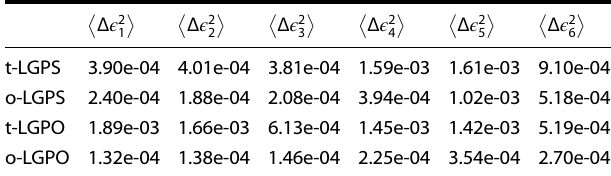
7. In turn, from these trajectories, we identify 47 uncorrelated blocks for t-LGPS (each block ~4 ps), 41 uncorrelated blocks for o-LGPS (each block ~4 ps), 16 uncorrelated blocks for t-LGPO (each block ~10ps), and 31 uncorrelated blocks for o-LGPO (each block ~5 ps). Next, we study the convergence of the elastic moduli on the simulation time. For each system we perform several calculations of the elastic moduli, each of them using only a part of the whole trajectory simulated, corresponding to n = 2, . . N blocks, N being the number of blocks that we have chosen for the whole trajectory (see above), and each block having the same length as determined from the block analysis on the whole trajectory. Then, for each of these calculations we obtain the standard errors of the moduli from the variance over the blocks, since these blocks are already uncorrelated and there is no need to repeat a block analysis for each of these calculations. The values of the moduli as a function of the simulation time, together with the related standard errors are reported in Fig. 4 for t-LGPS, whereas for the remaining three structures they are reported in Supplementary Figure 8. In Fig. 4, the errors of B , G , E, and ν decrease, and their absolute values converge, while increasing the simulation time. A similar behavior is shown by o-LGPS and o-LGPO (Supplementary Figures 8a, c). For t-LGPO (Supplementary Figure 8b) we have a totally different scenario: the moduli are